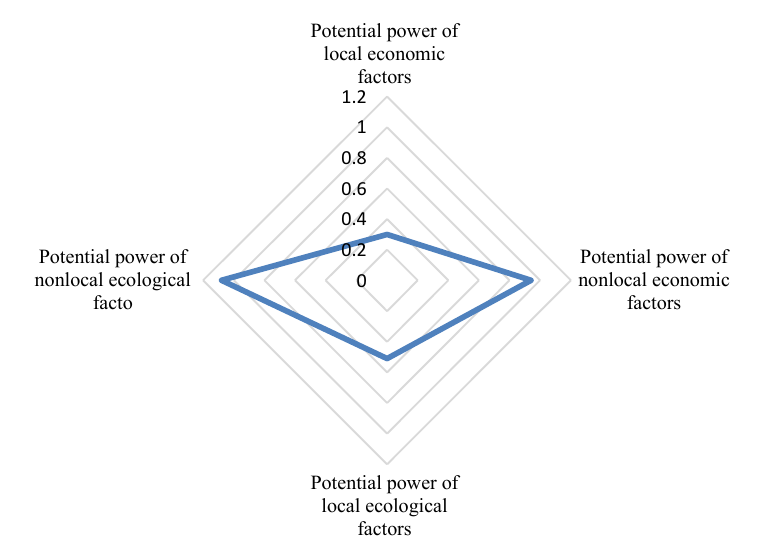
Fig. 4. Diagram of private potentials’ indicators influence for the analysed